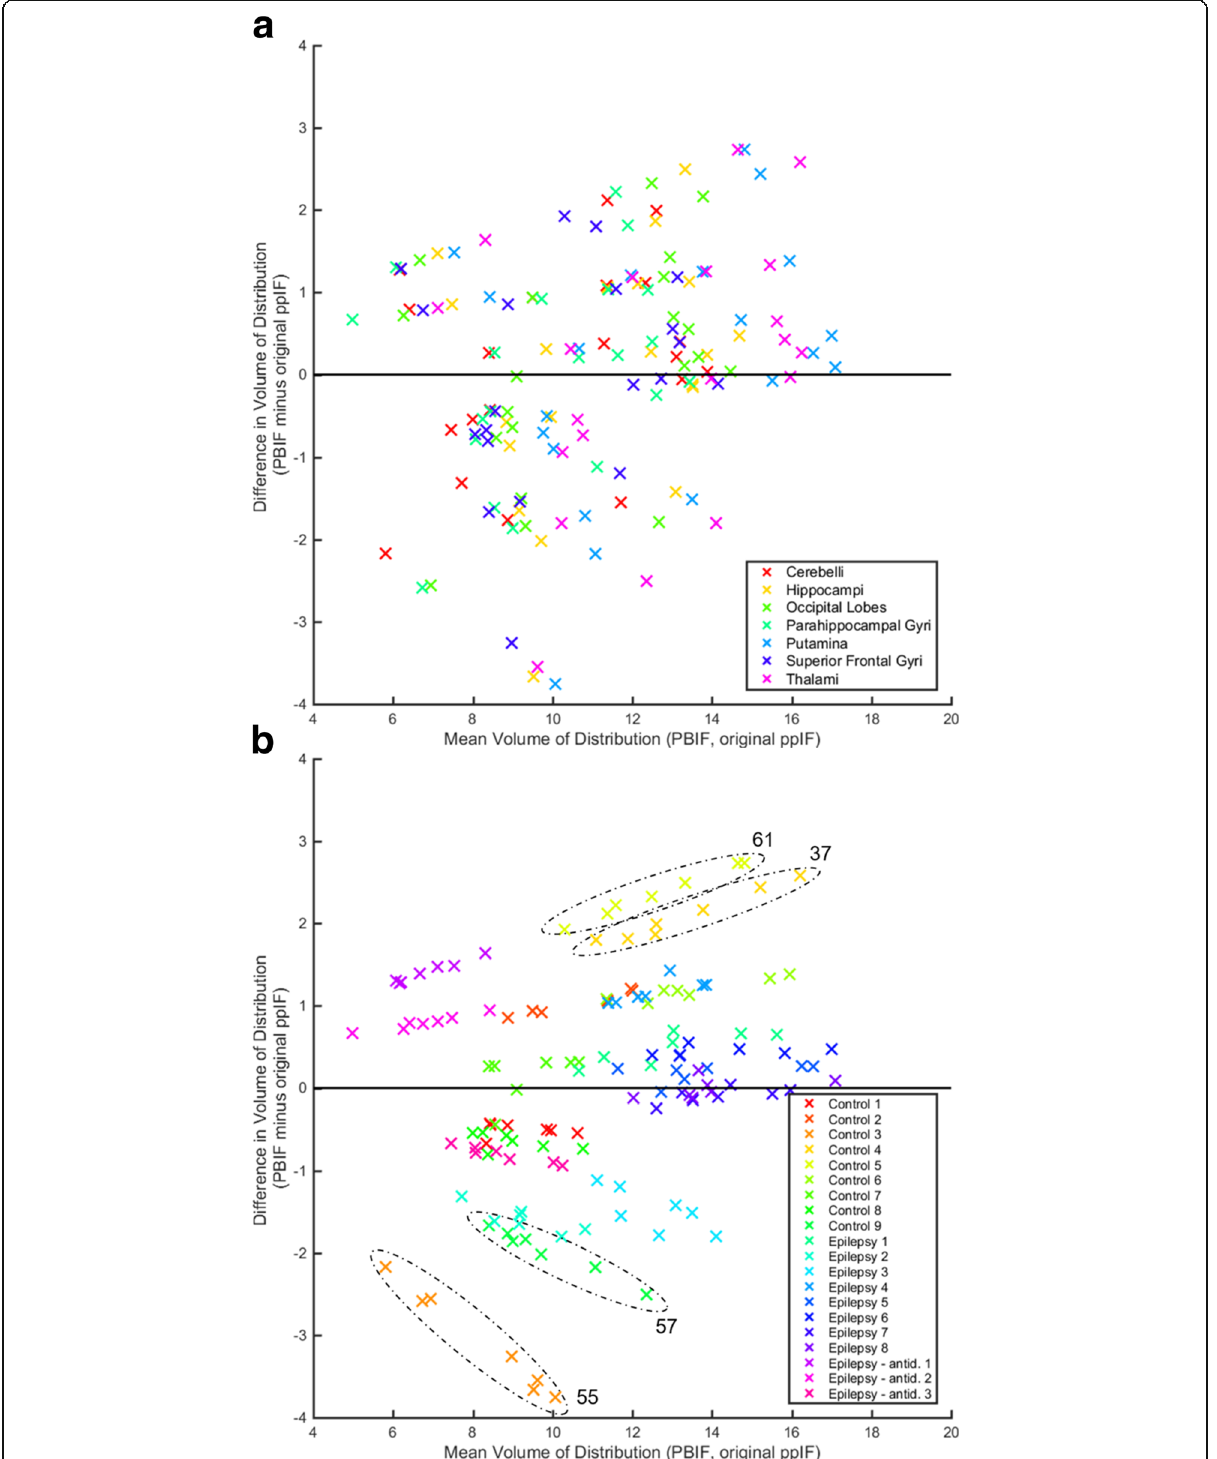
Fig. 2 Bland – Altman plot for V T calculated using PBIFs versus using the original ppIFs. V T s were calculated using 90-min datasets. The colour scale depicts ROI ( a , top) or participant identification ( b , bottom). The dash ovals identify participants with large differences in V T , with their age in years (the median age of participants was 35 years, interquartile range 26 – 50 years, range 20 – 62 years). antid., on